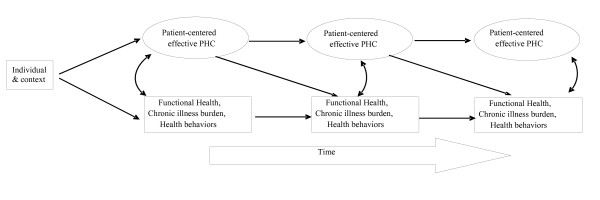
Conceptual Model.